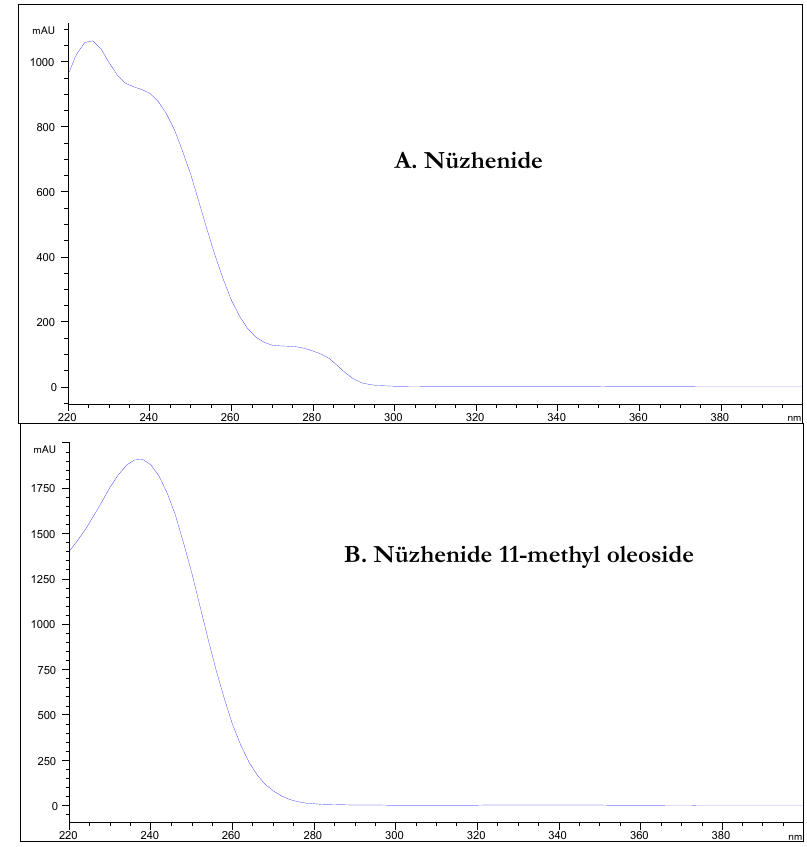
Figure 4. UV-Vis spectrum of ( A ) nüzhenide and ( B ) nüzhenide 11-methyl oleoside.